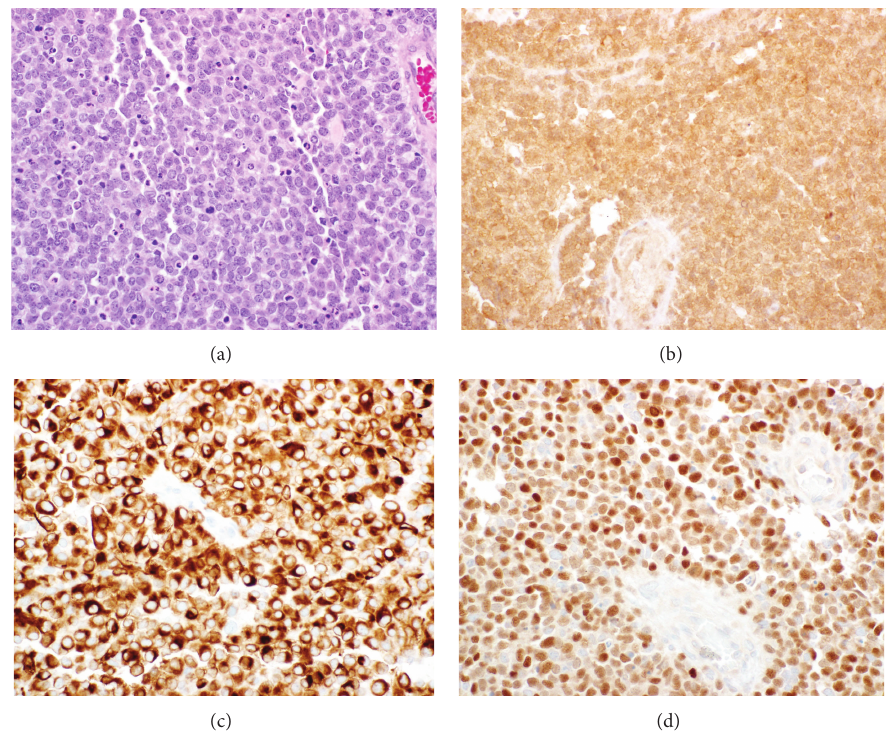
Figure 1: Photomicrographs of diagnostic biopsy demonstrating rhabdomyosarcoma. (a) 40x magnification of hematoxylin- and eosin-stained section demonstrating diffuse small round cells with a high nuclear to cytoplasmic ratio. (b) 40x magnification of horseradish peroxidase immunohistochemical stain for IGF1-R demonstrating uniform expression. (c) 40x magnification of horseradish peroxidase immunohistochemical stain for desmin demonstrating cytoplasmic expression. (d) 40x magnification of horseradish peroxidase immunohistochemical stain for myogenin demonstrating nuclear